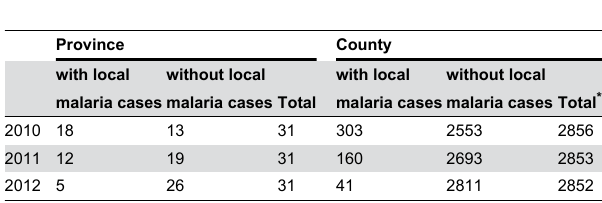
*. the numbers of counties changed due to splitting the combined county and/or combining the divided